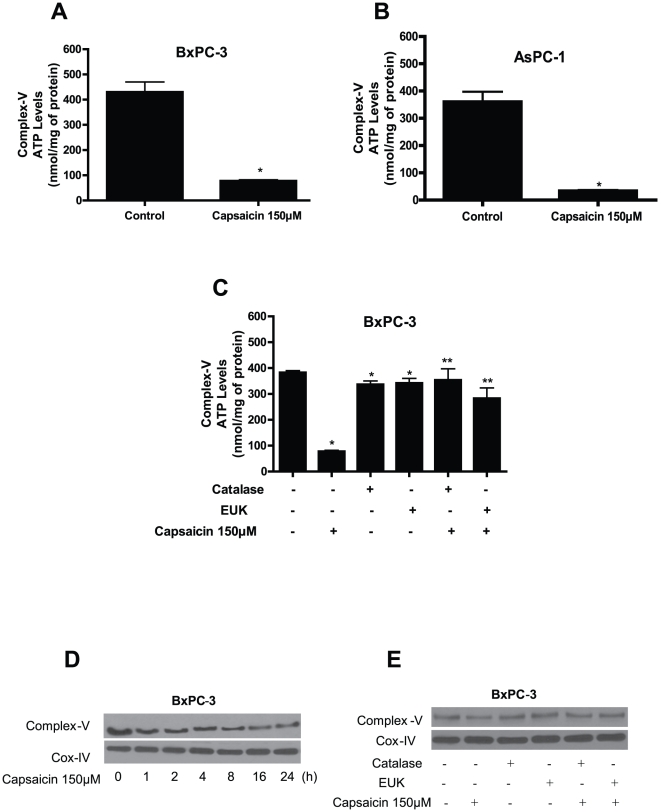
Effect of capsaicin on mitochondrial ATP-synthase (complex V) activity.(A) BxPC-3 (B) AsPC-1 cells were treated with DMSO or 150 µM capsaicin for 24 h, and (C) BxPC-3 cells were treated with catalase (2000 U/ml) or EUK-134 (50 µM) 1 h prior to 150 µM capsaicin treatment for 24 h and ATP-synthase activity was determined in pure mitochondria protein isolated from control and treated cells as described in the method section. Results are expressed as mean ± SD (n = 3) of three independent experiments. *Statistically significant when compared with control or ** statistically significant when compared with capsaicin treatment, as analyzed by one-way ANOVA followed by Bonferroni's post-hoc test (P<0.05). (D) Effect of capsaicin treatment on complex-V protein expression. BxPC-3 cells were treated with DMSO or 150 µM capsaicin for indicated time periods or (E) BxPC-3 cells were treated with catalase (2000 U/ml) or EUK-134 (50 µM) for 1 h prior to treatment with 150 µM capsaicin for 24 h. Expression of complex-V protein was determined by immunoblotting in the pure mitochondrial protein as described in the method section. Each blot was stripped and reprobed with anti-Cox-IV antibody to ensure equal protein loading. These experiments were performed three times independently with similar results obtained in each experiment.